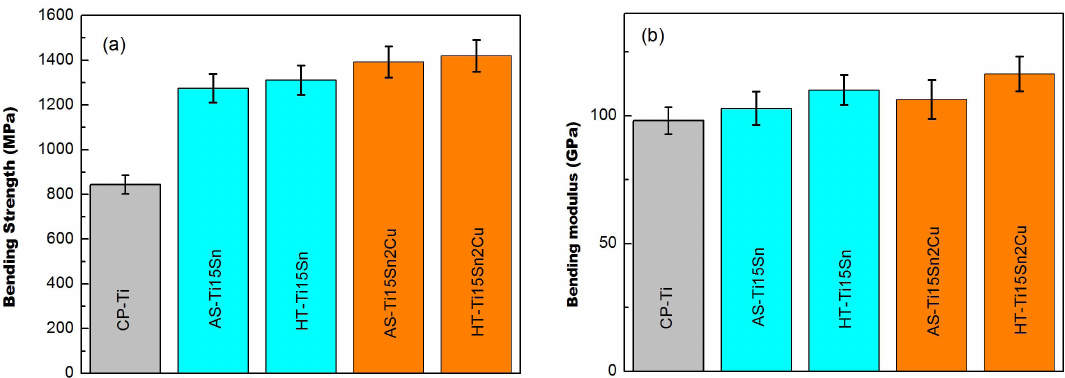
Figure 4. Bending property of Ti15Sn x Cu under different treatment condition: (a) bending strength and (b) bending